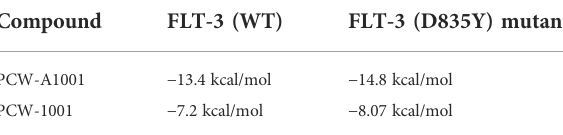
TABLE 1 Binding free energy calculation for PCW-A1001 with WT and mutant FLT-3.